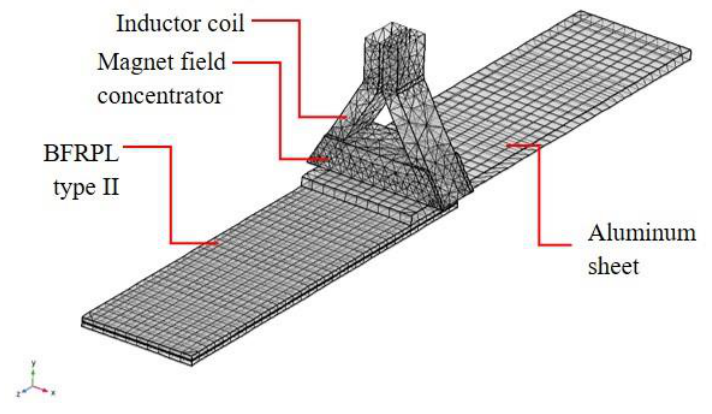
Figure 5. COMSOL model description showing the simulation assembly.